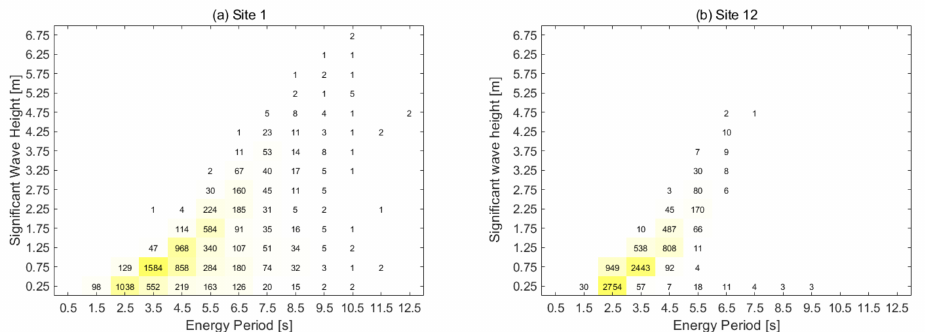
Figure 4. Scatter diagram for significant wave height and energy period at the two research sites. The locations of two research sites: ( a ) Site 1 and ( b ) Site 12 are presented in Figure 2a. In the diagrams, the number given in each square is the average occurrence in hours per year, which is based on an eight-year average